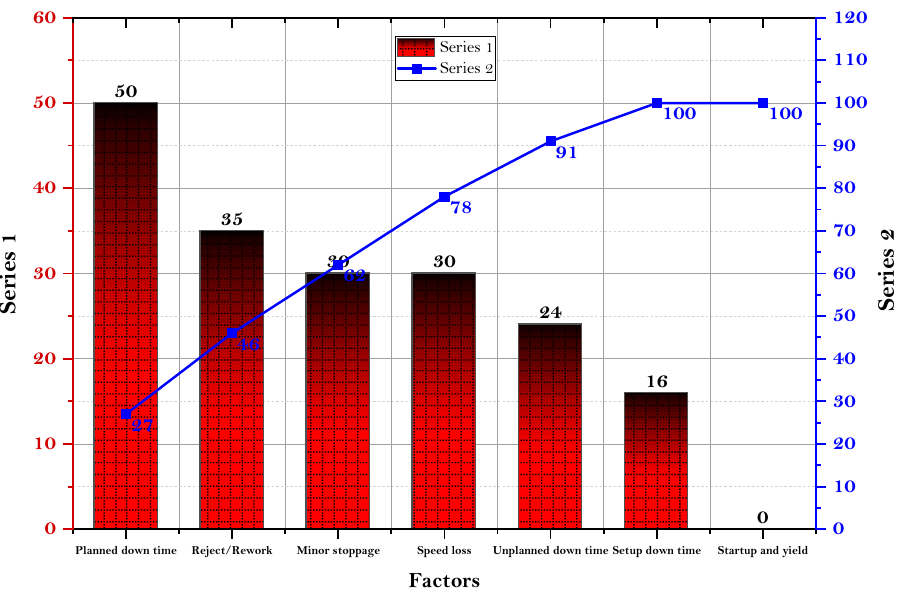
Figure 4. First Level Pareto analysis of big losses in OEE.